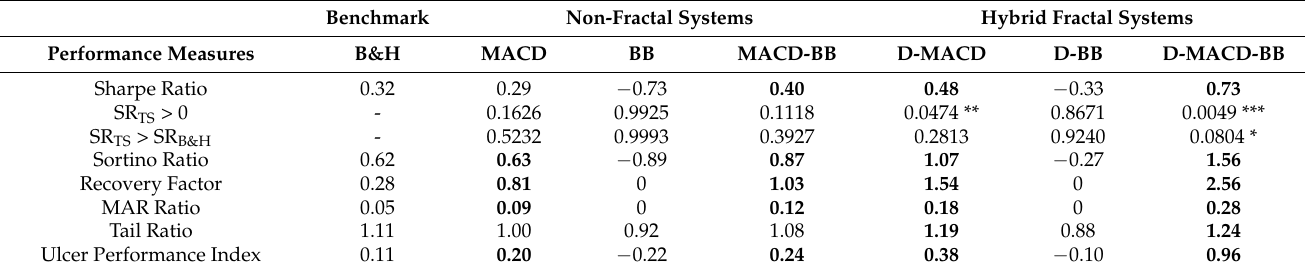
Table 3. Risk-return metrics of the technical trading systems and the benchmark.